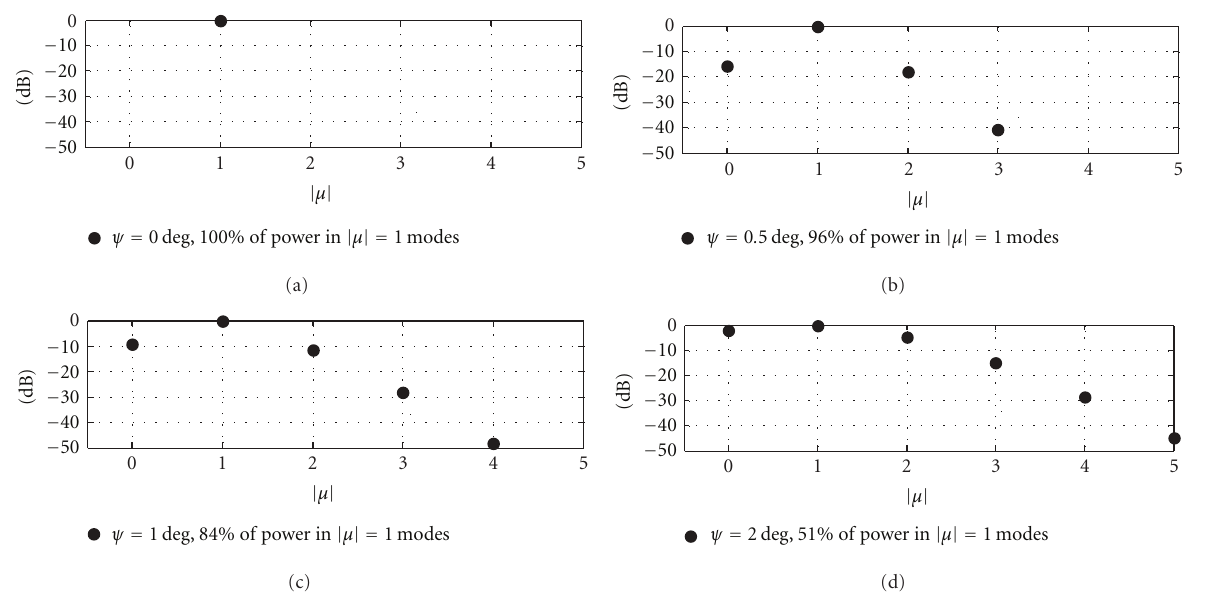
Figure 3: The power in the modes of test probes with ψ equal to 0 ◦ , 0 . 5 ◦ , 1 ◦ , and 2 ◦ . The power for each value of | μ | = K is obtained by summing the power of all modes with μ = ± K . The plots are normalized so that the power in the μ = ± 1 modes is